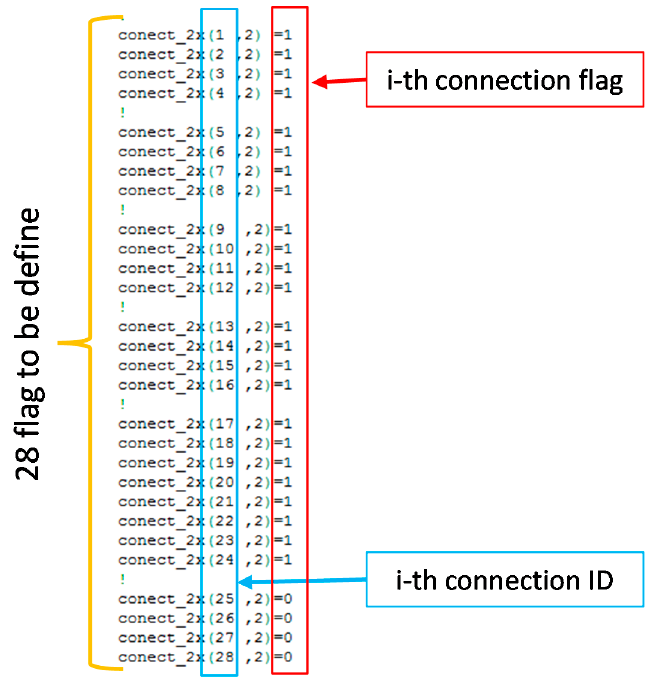
Figure 9. Flag definition for Unit Cell connection.